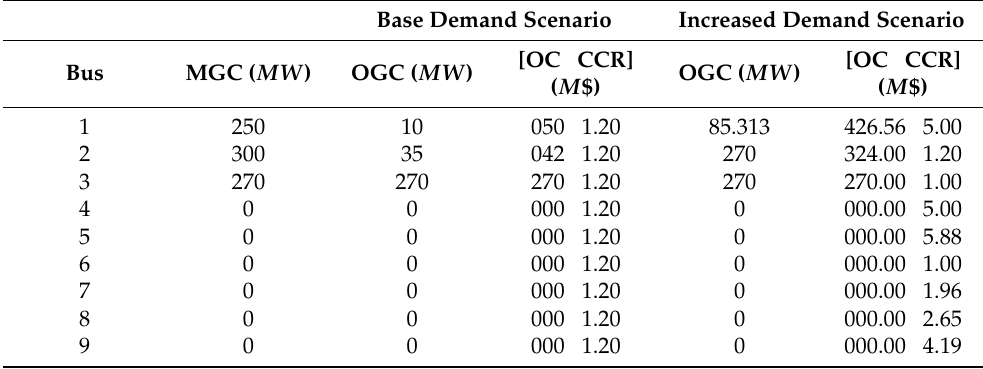
Table 6. Results of the base year—optimal generation capacity versus optimal generation capacity with demand increase in a 9-bus system.